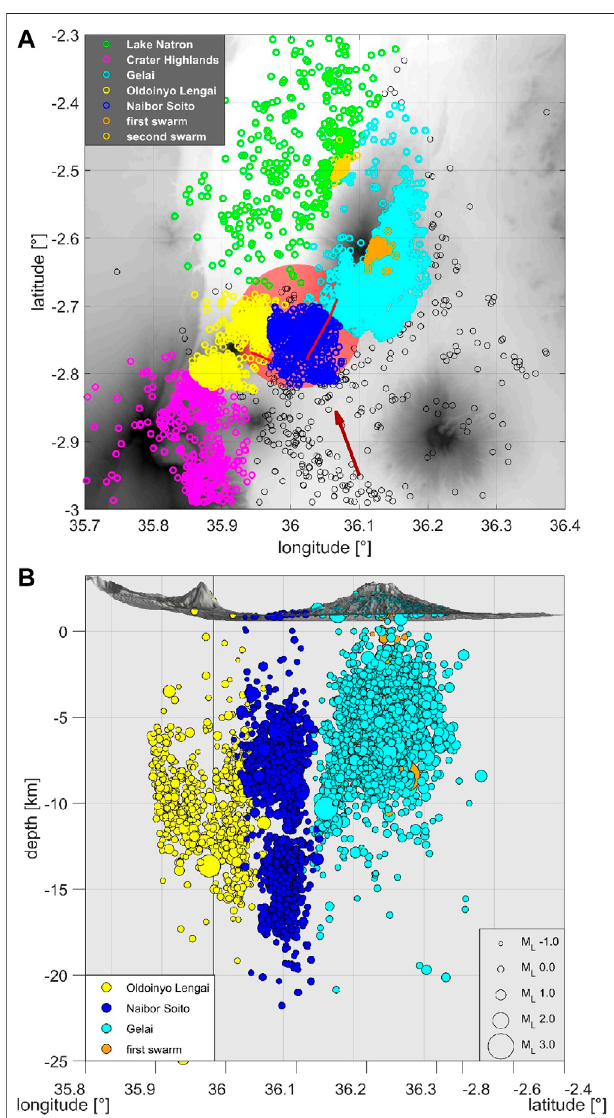
FIGURE10|(A) Mapviewofearthquakes(opencircles)groupedbyarea: (1) yellow for Oldoinyo Lengai, (2) blue for Naibor Soito, (3), cyan for Gelai, (4) magenta for Crater Highlands, (5) green for Lake Natron. The two swarms are shown in orange and gold. Inferred dikes are shown as red lines (Calais et al., 2008; Biggs et al., 2013) and roughly dimensioned magma chamber in shaded-red inferred from Roecker et al. (2017). Purple arrow shows view angle in (B) . (B) VerticalCross-sectionof (A) looking − 20 ° N.Circlesshowearthquakes and are colored by group and scaled by their magnitude.